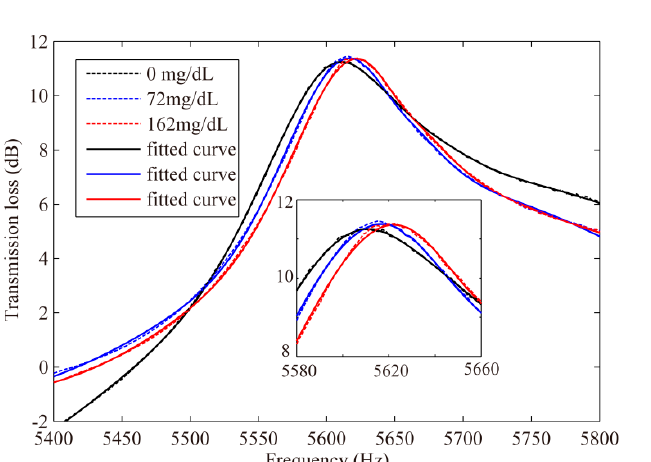
Figure 4. Spectrum of transmission loss at human blood glucose levels obtained by experiment.